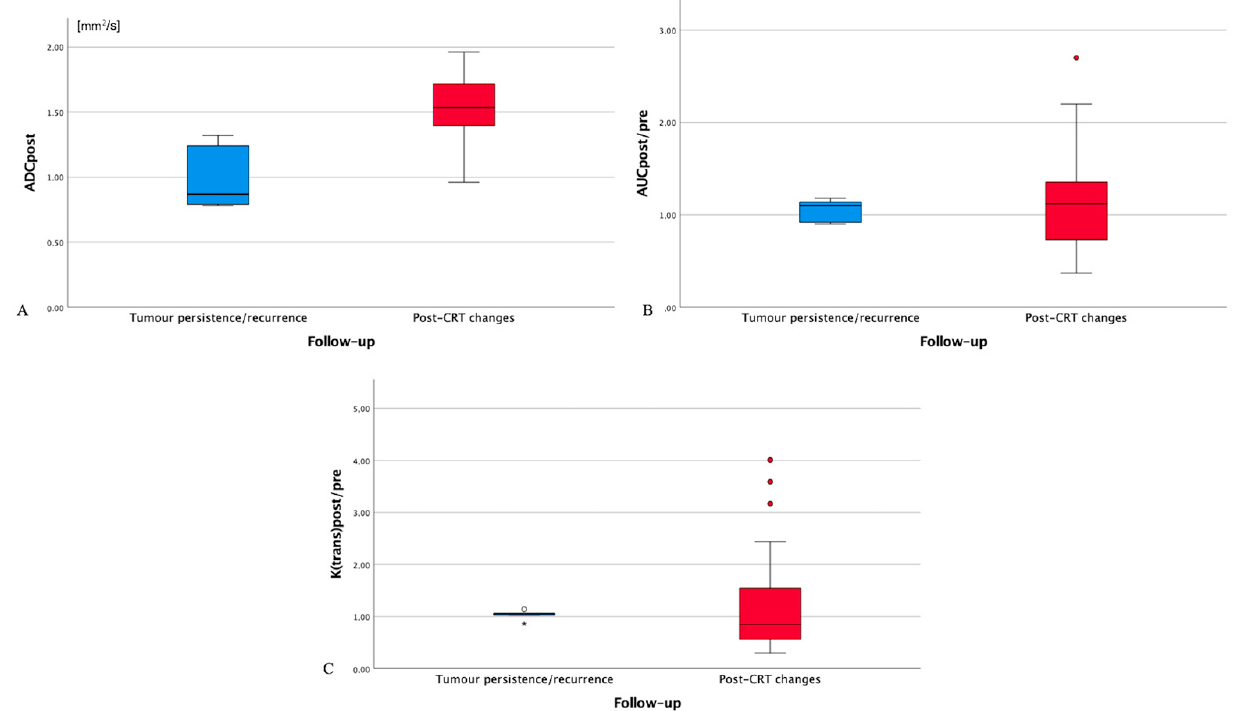
Figure 1. Receiver operating characteristic (ROC) curves for ADCpost values ( A ), ADCpost-pre% ( B ), ADCpost-pre values ( C ), and ADCpost/muscle values ( D ). ADC: apparent diffusion coefficient. ADCpost: residual tissue mean ADC value.